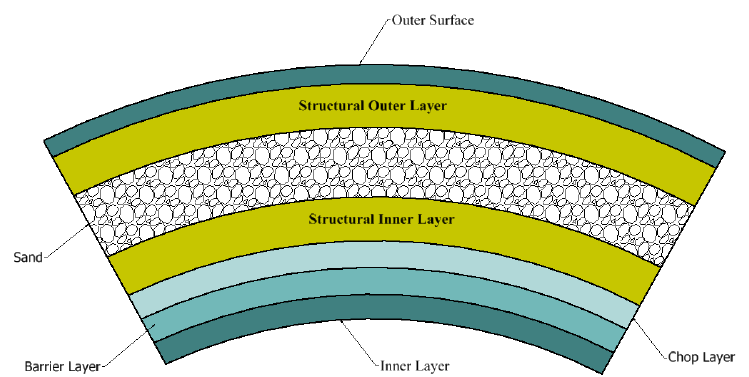
Figure 1. Cross-sectional view of